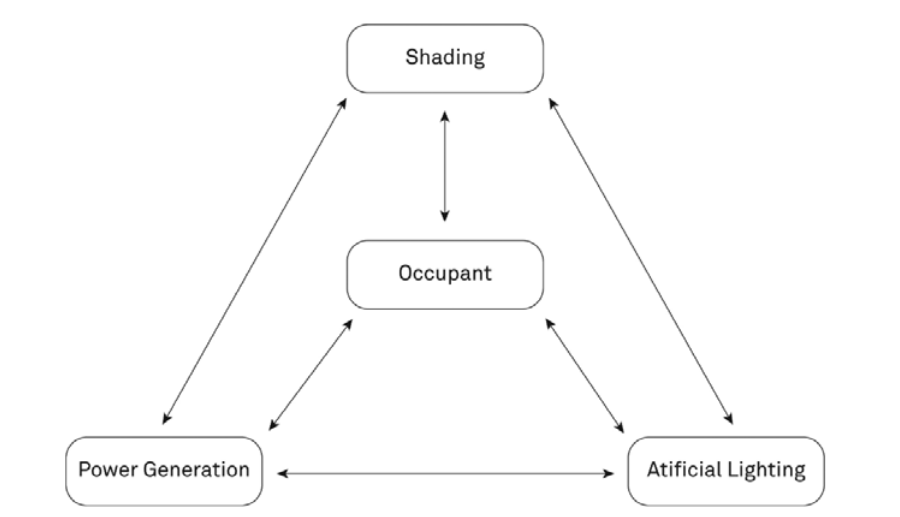
Figure 3. The importance of the occupant in each factor (source: Rossi, Nagy and Schlueter, 2012).